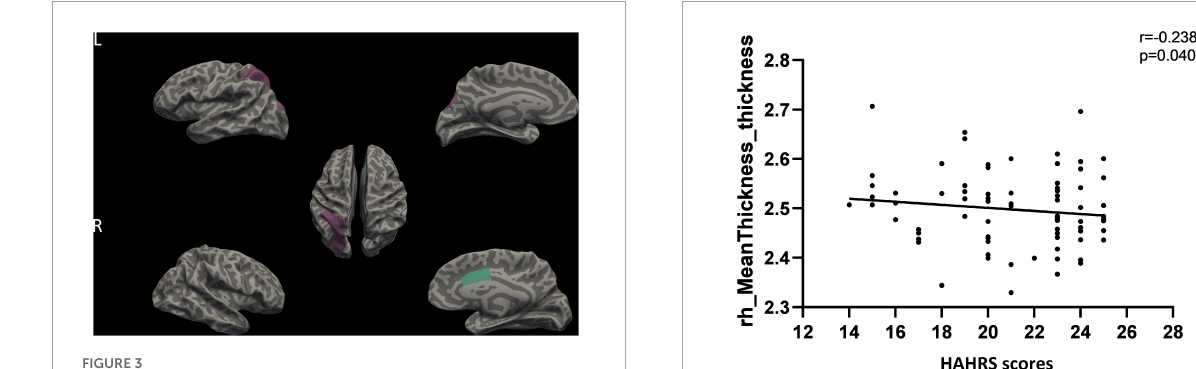
FIGURE5 The mean cortical thickness in the right hemisphere was negatively correlated with the severity of auditory verbal hallucination, as assessed by HAHRS